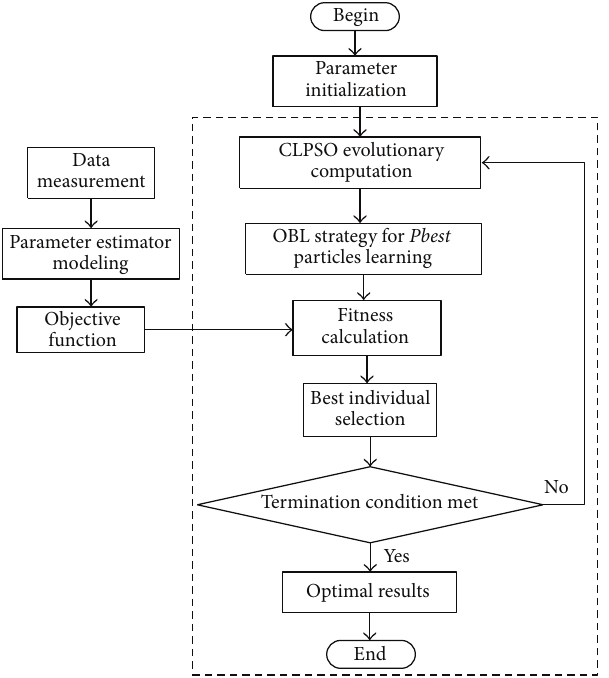
Figure 3: The process of parameter estimation in PMSM based on CLPSO-OBL.